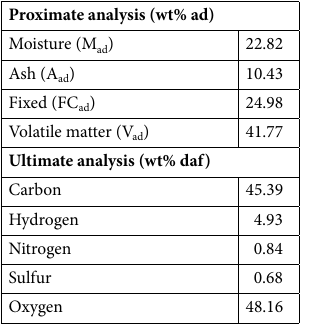
Table 1. Proximate and ultimate analyses of coal samples.